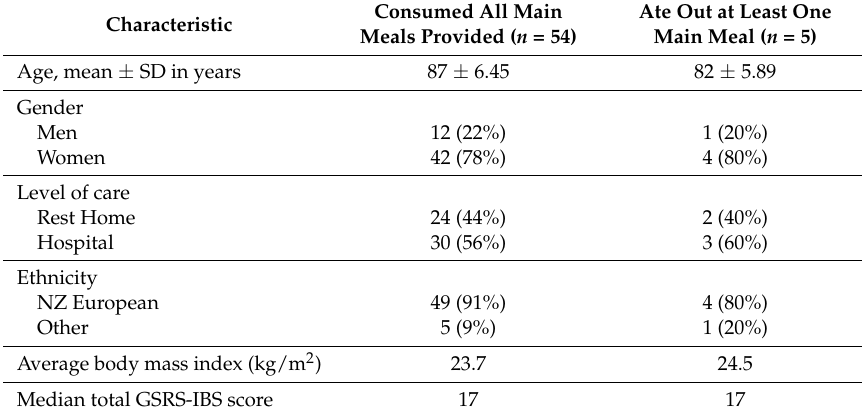
Table 3. Demographics and median total GSRS-IBS scores of 54 participants who consumed all three main meals at the facility and 5 participants who ate out at least one main meal.